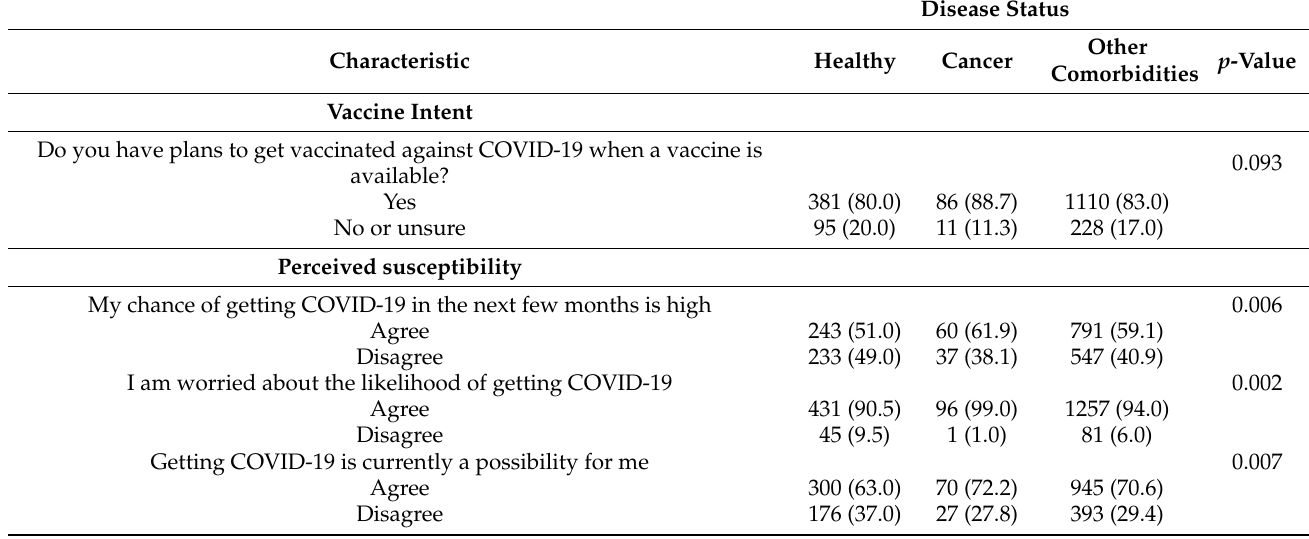
Table 2. Bivariate association between vaccine hesitancy predictors and disease status among adults in